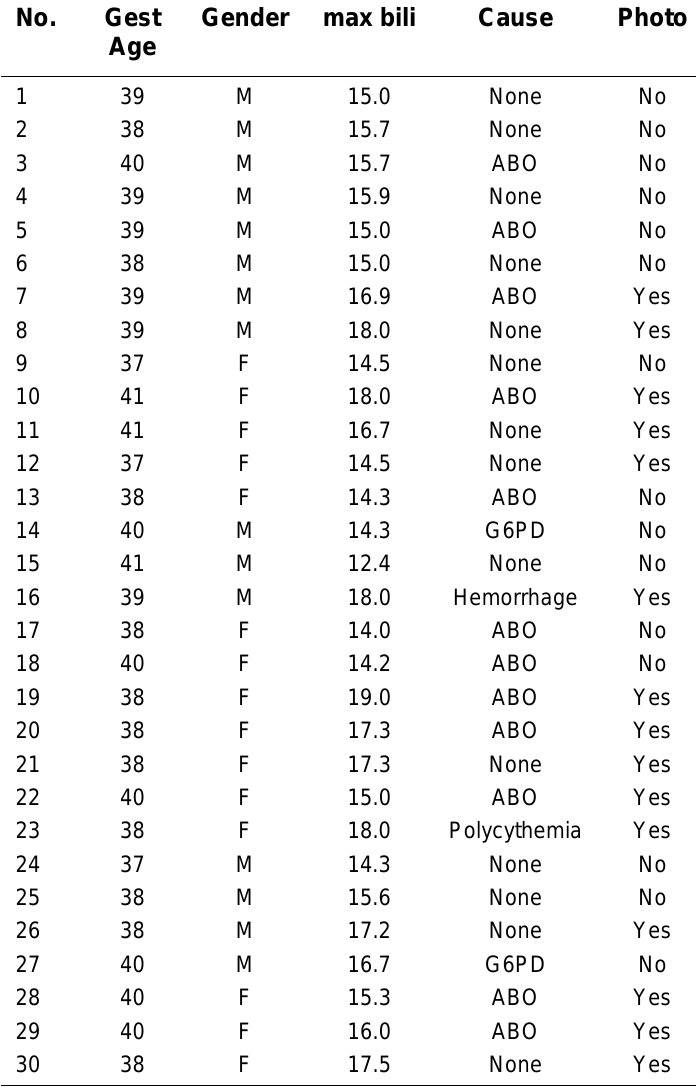
Hyberbilirubinemia After the First